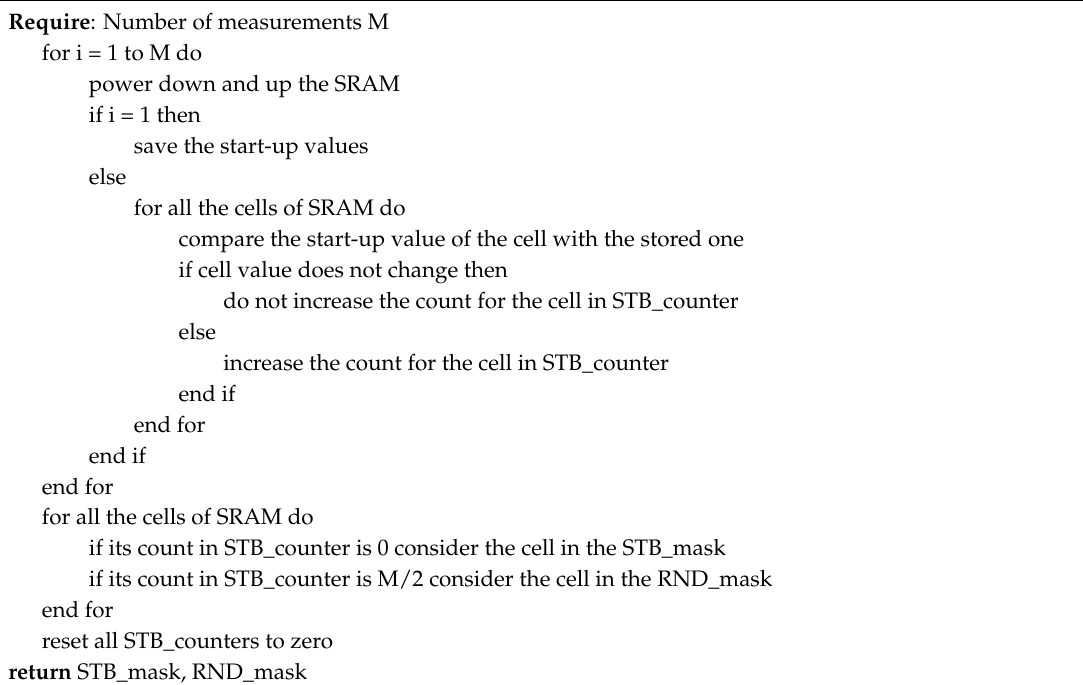
Algorithm 1 Pseudo-code of STB and RND masks extraction